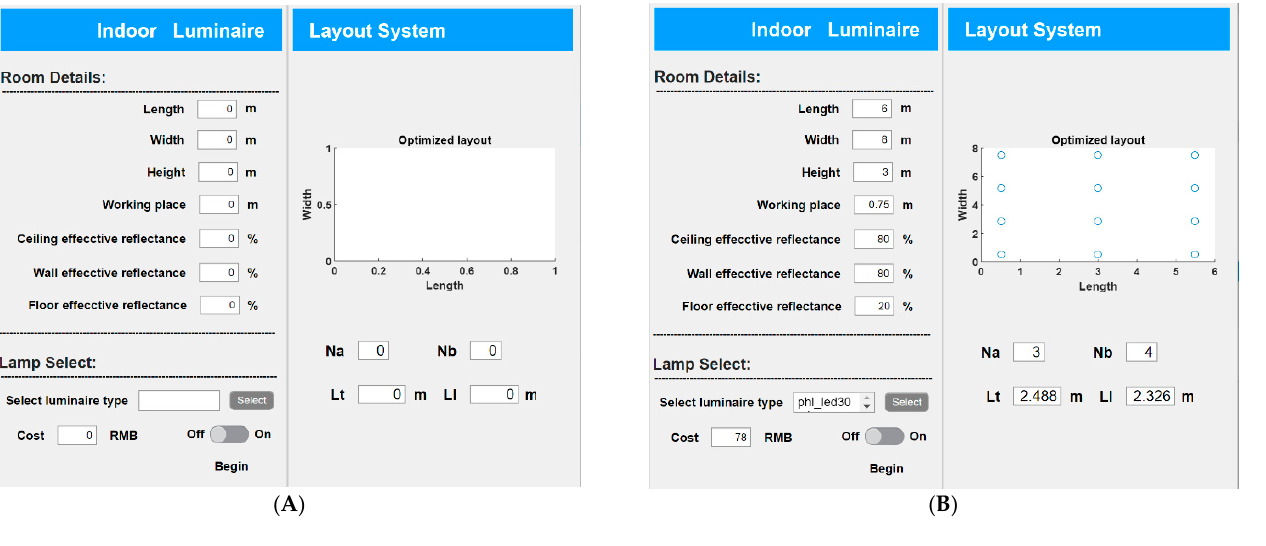
Figure 12. Interface of the Indoor Luminaire Layout System. ( A ) Beginning interface and ( B ) result interface of an example.